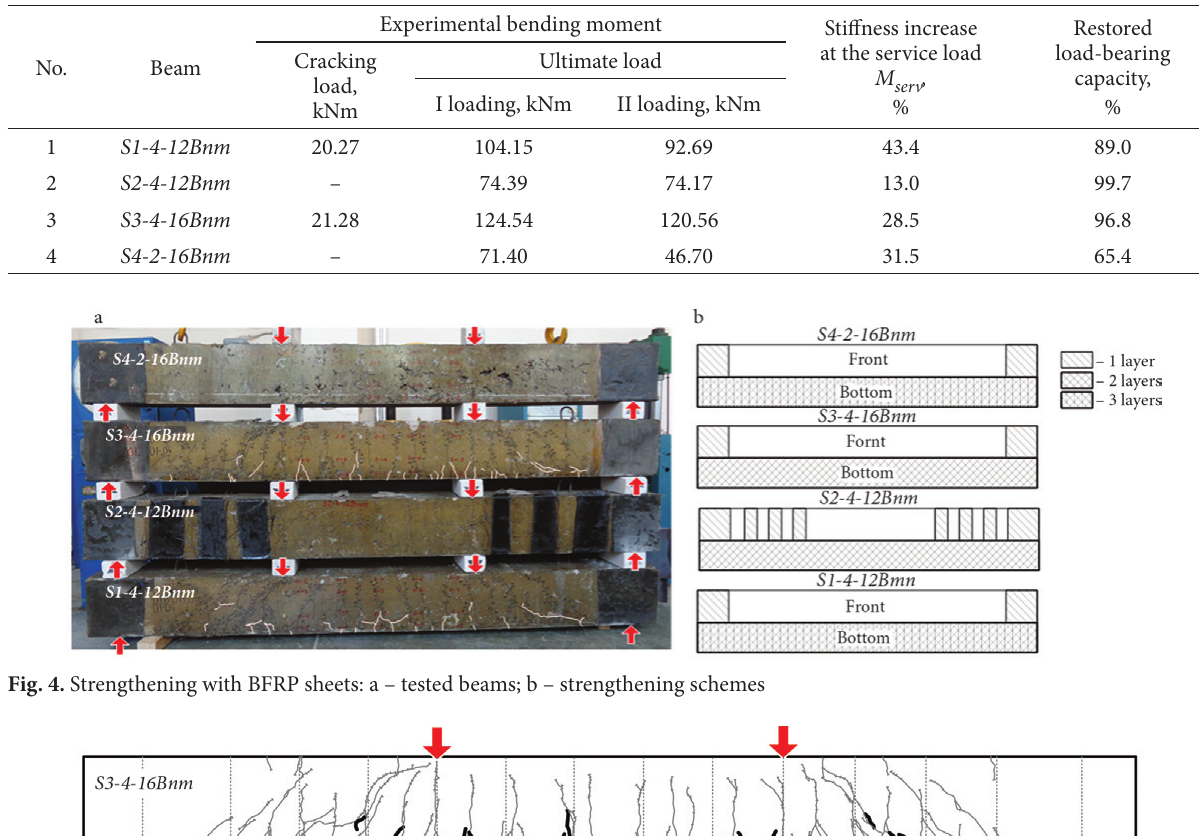
Table 4. Characteristics of the tested